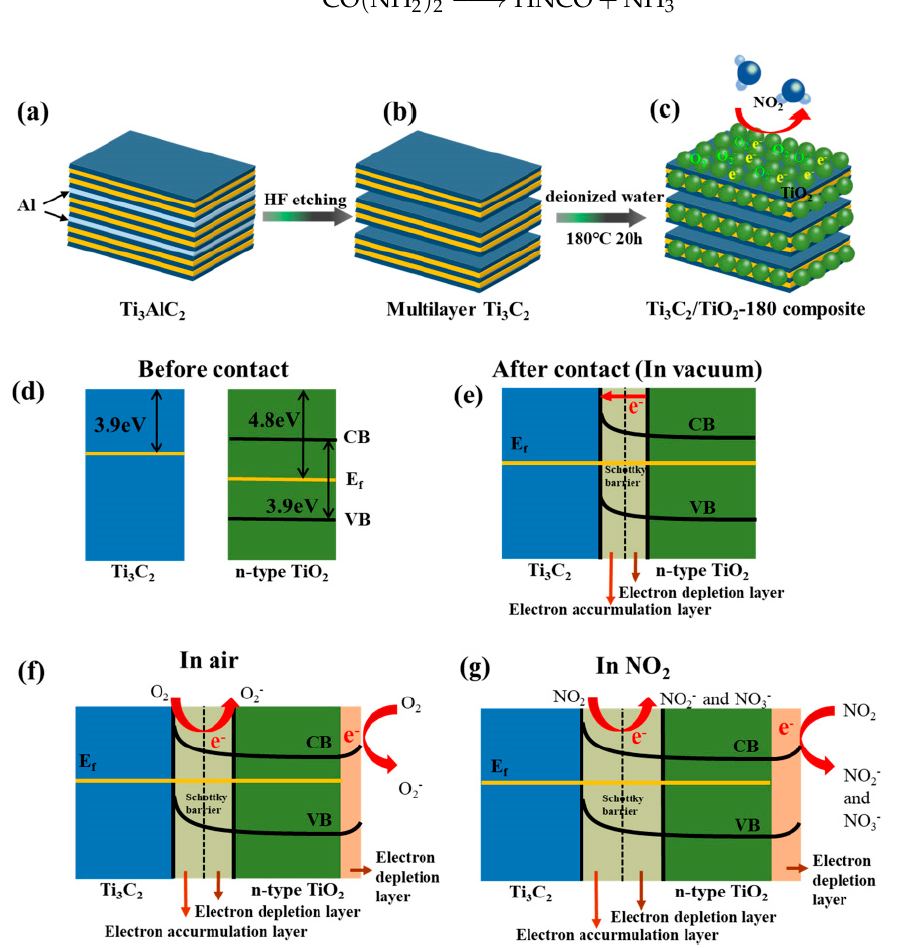
Figure 14. ( a – c ) Schematic illustration of the preparation process of Ti 3 C 2 /TiO 2 composite; ( c ) Adsorption model of NO 2 gas; ( d ) Band structures of Ti 3 C 2 and TiO 2 before contact; ( e – g ) Variation of Schottky barrier of Ti 3 C 2 /TiO 2 composite under different conditions. Reprinted with permission from [111]. Copyright 2021: Elsevier B.V.